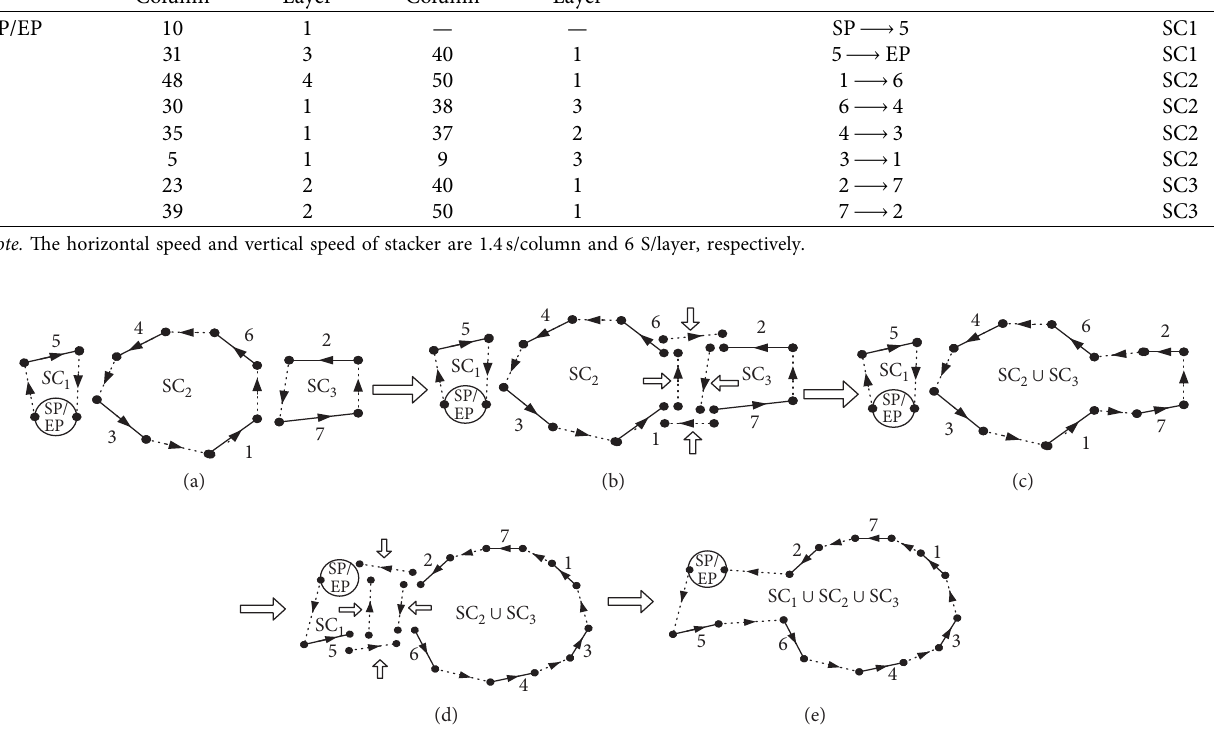
Figure 6: Minimum cost merging process of subloops of the example shown in Table 2. (a) Three subloops determined by assignment. (b) Minimum cost merging scheme. (c) New subloops after minimum cost merging. (d) Minimum cost merging scheme. (e) Tour after minimum cost merging.